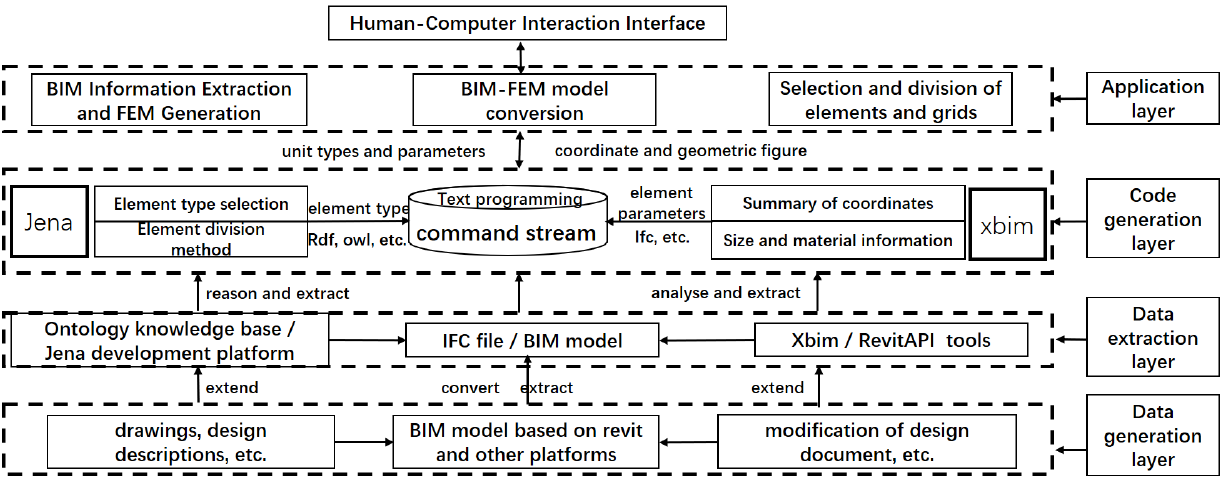
Figure 10. Software architecture Design of BIM-FEM.